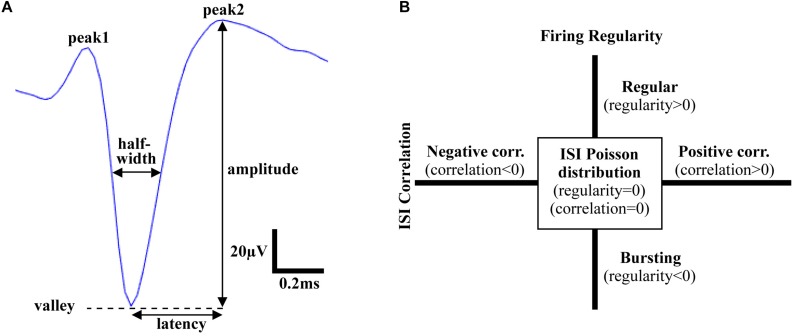
Time domain features of action potentials. (A) Waveform shape features. Amplitude: voltage from valley to peak; Latency: time from valley to the 2nd peak; Half-width: width at half amplitude; Asymmetry: ratio of amplitude of the 1st peak and the 2nd peak. (B) Firing pattern features. Firing regularity: the logarithm of the shape factor κ of the gamma distribution fitted to the interspike intervals (ISIs). A spike train was considered Poisson random if its ISIs were exponentially distributed (κ = 1 or log κ = 0), whereas it was considered regular if log κ > 0 or bursting if log κ < 0; ISI correlation: the Spearman’s rank-order correlation calculated for sequentially paired ISIs indicated whether consecutive ISIs were positively correlated or negatively correlated.